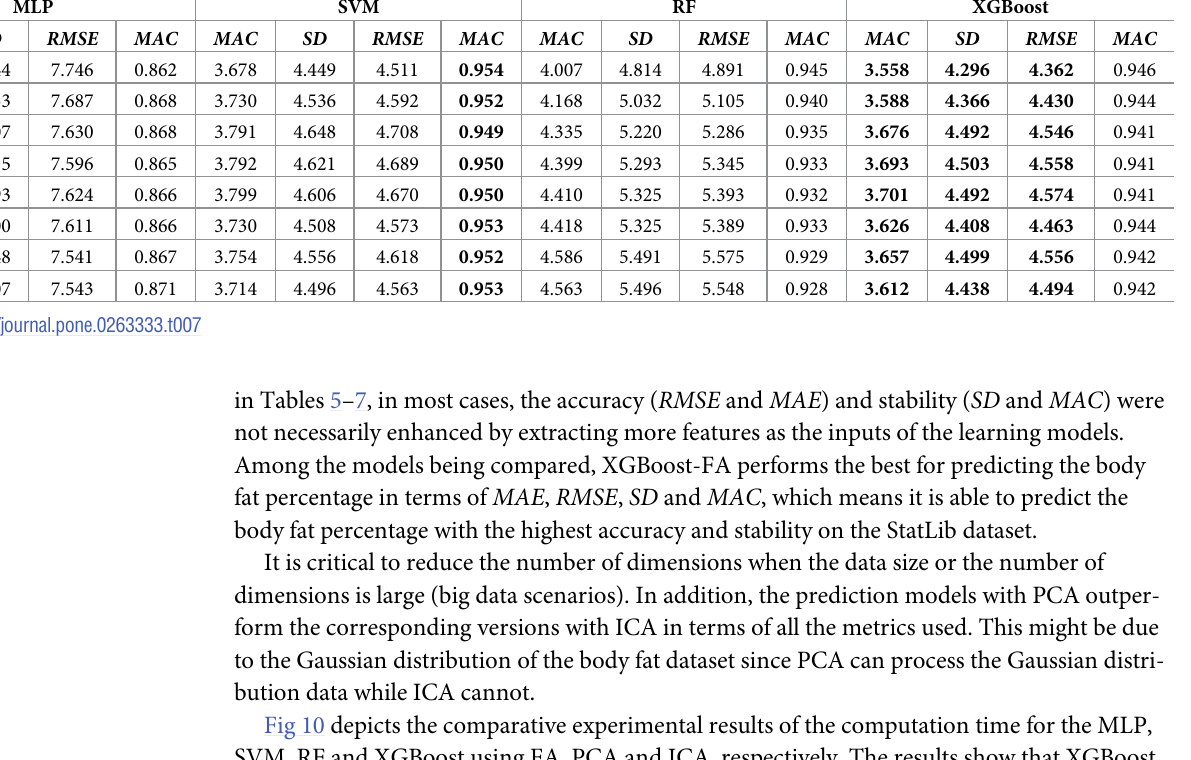
PLOS ONE | https://doi.org/10.1371/journal.pone.0263333 February 22,